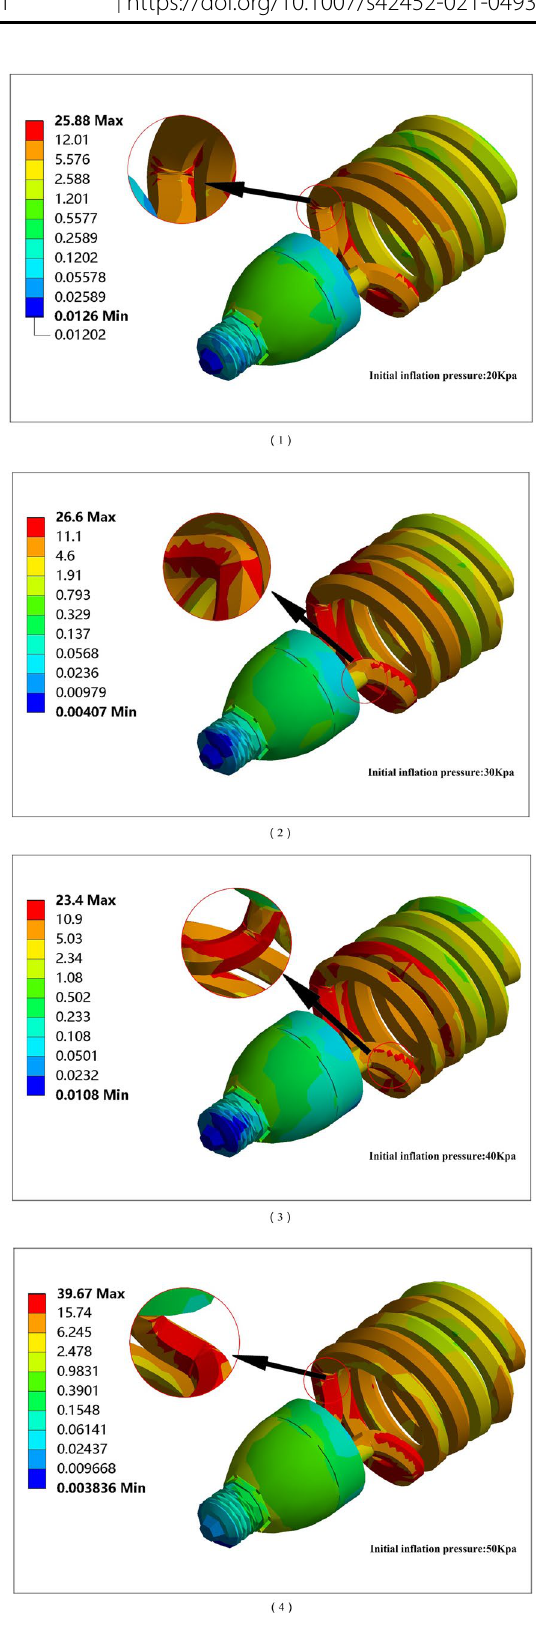
Fig. 9 Maximum stress distribution diagram of energy-saving lamps with different inflation